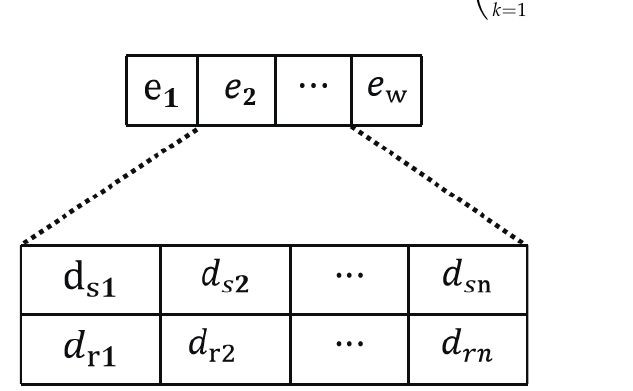
Figure 4. Structure of historical knowledge.